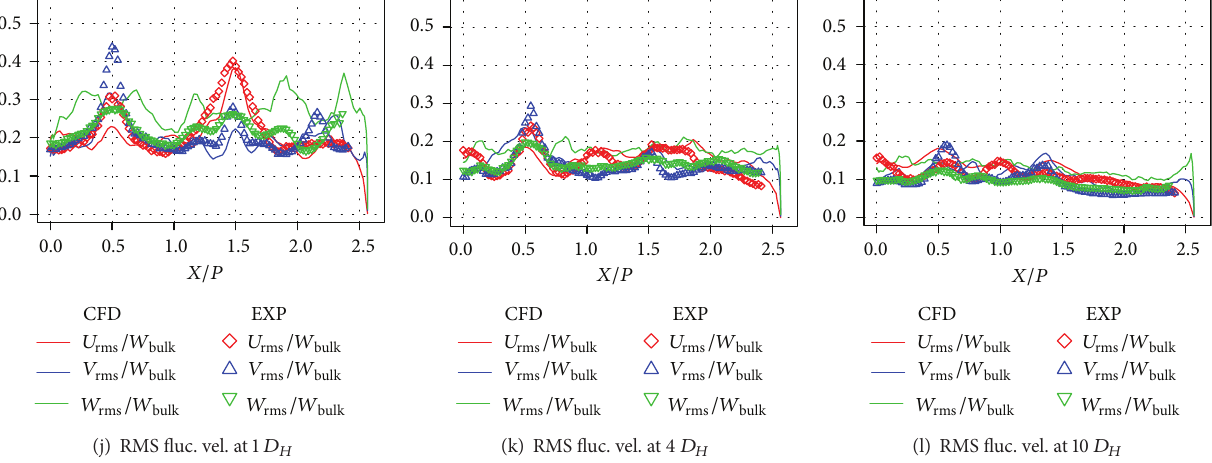
Figure 15: Mean and RMS velocity components at 𝑦 elevation for split spacer-grid type. The horizontal axis represents normalized distance core from the center of the channel to the wall, while the vertical represents normalized velocities or RMS fluctuations.